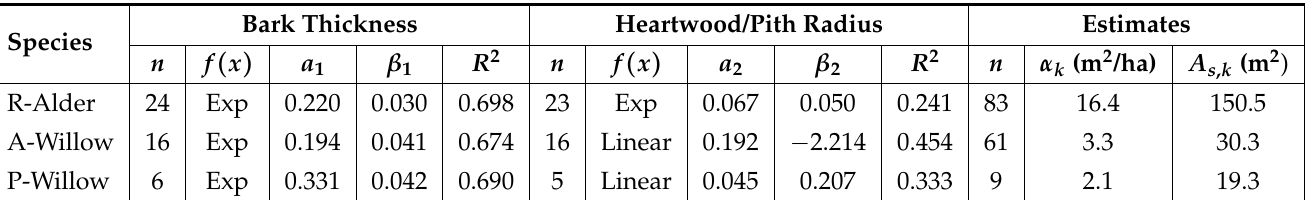
Table 2. Model parameters for the best fit developed from wood core data within the six sample plots to estimate bark thickness and heartwood/pith radius based on DBH. Estimated fractional sapwood basal area, α k , and total sapwood area, A s , k for each phreatophytic species across the riparian forest within the study area are also included.